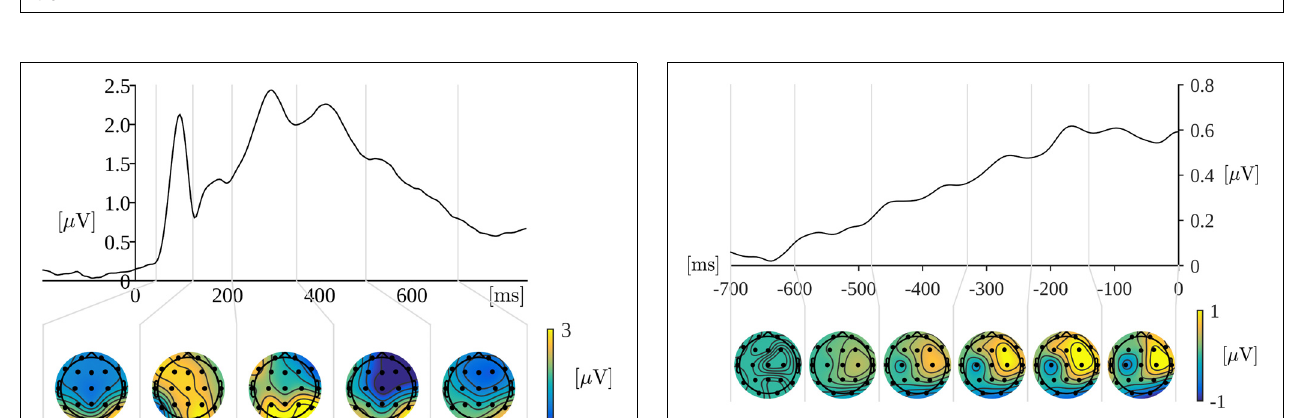
FIGURE 3 | Outline of the experimental procedure. The task for participants was to select the QR-code best representing the word displayed at the beginning of a trial.